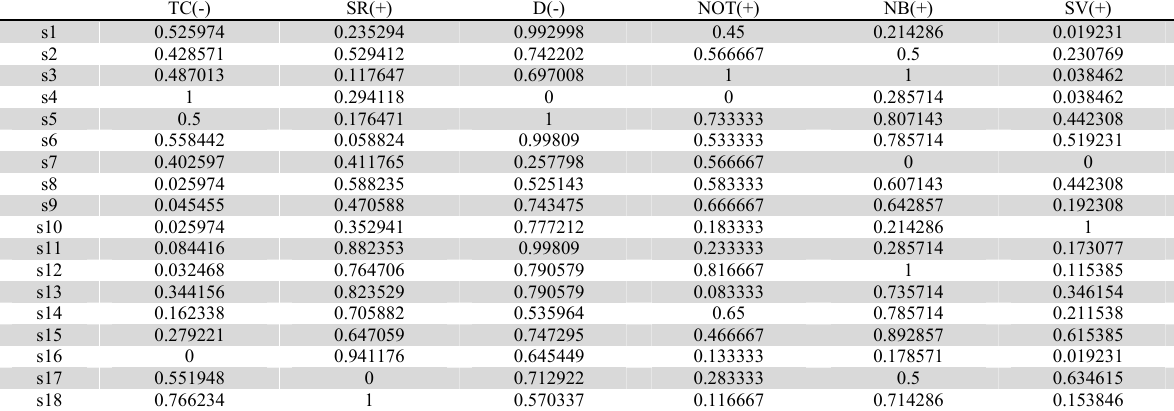
The results of the second step of the proposed GRM